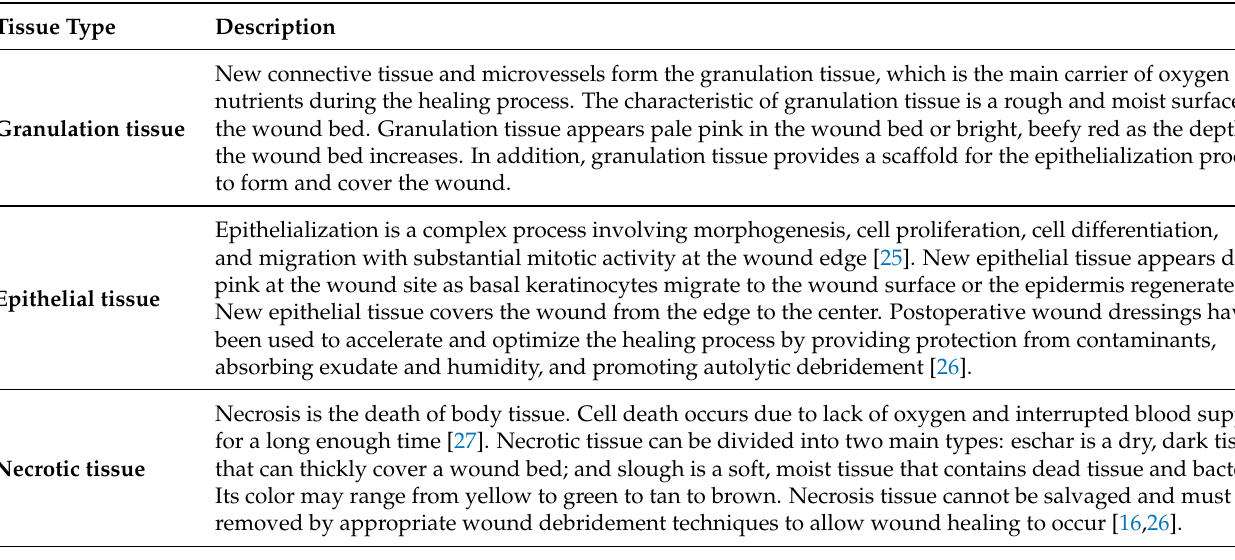
Table 2. Three types of wound